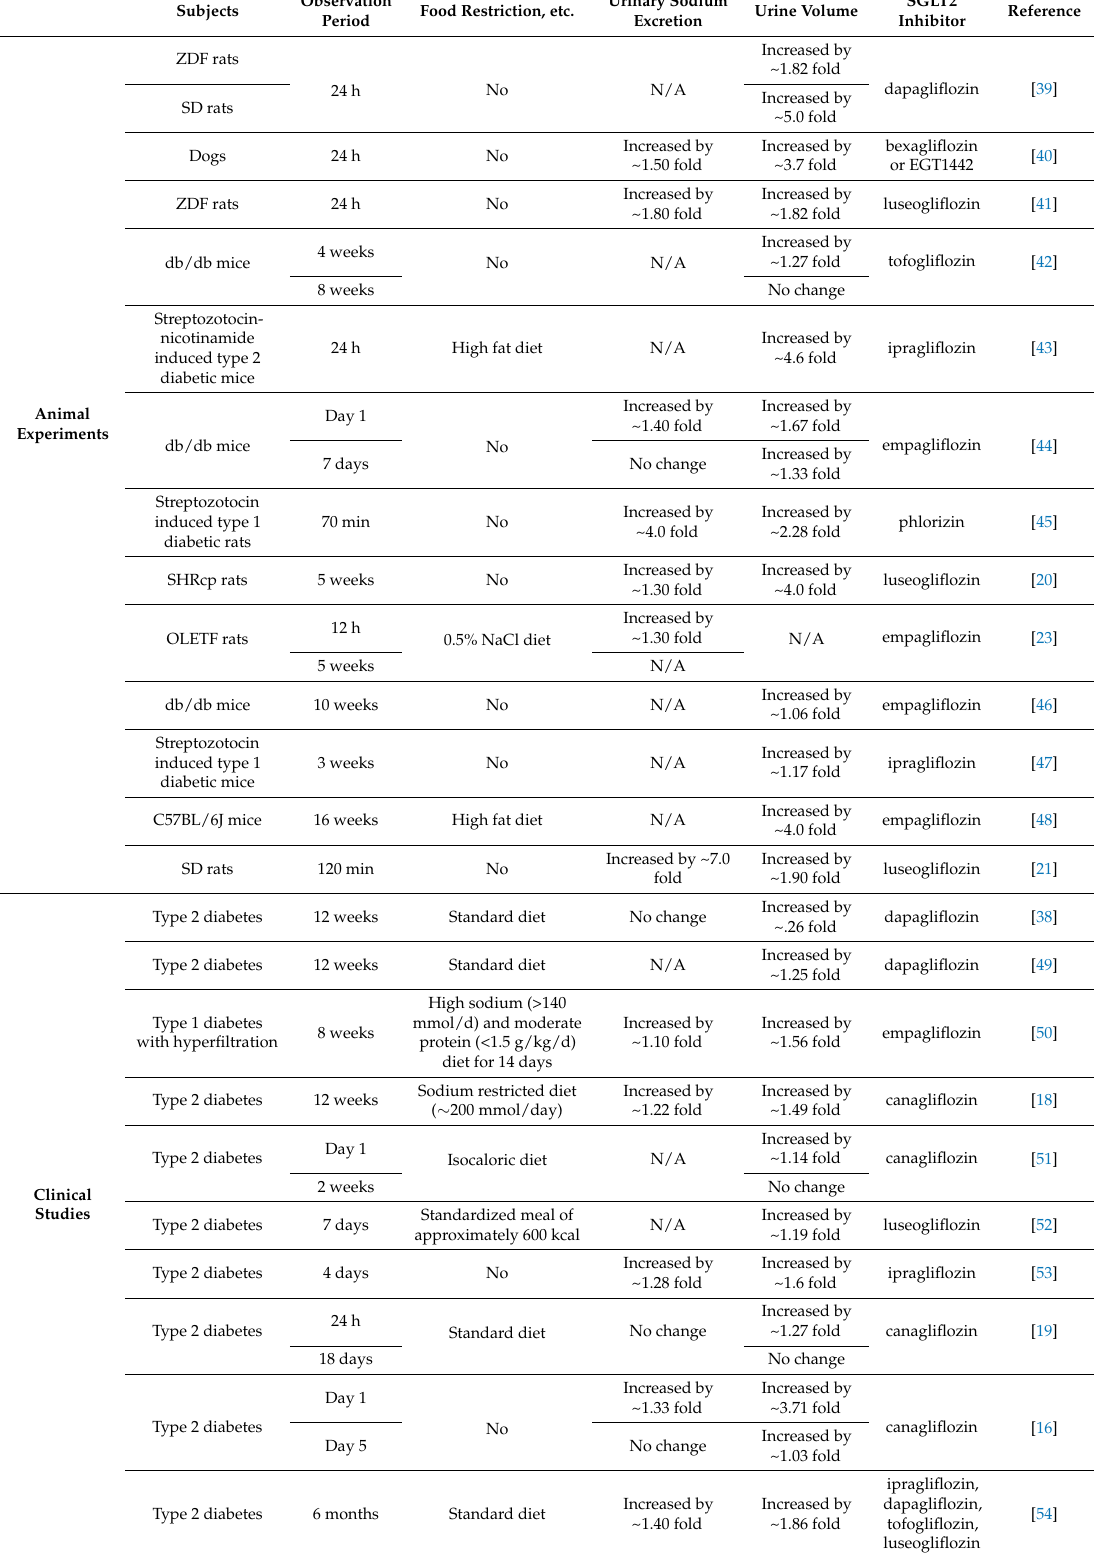
Table 1. SGLT2 inhibitor-induced changes in urine volume and urinary sodium excretion. Subjects Observation